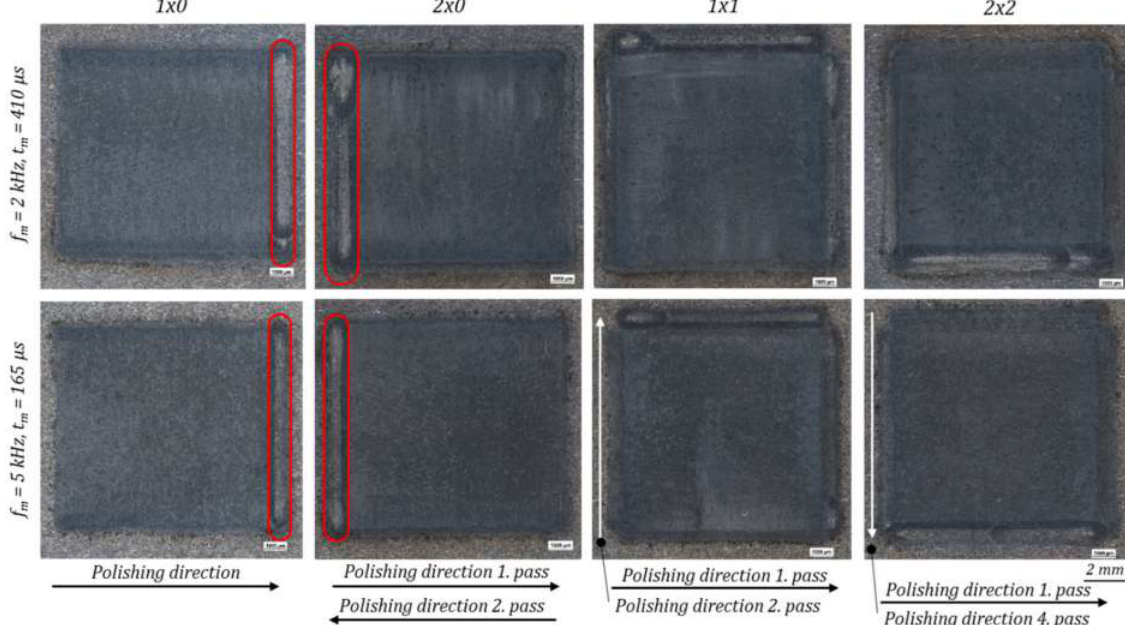
Figure 22. Microscopic images of the laser polished surface with multiple polishing passes (2 × 0, 1 × 1 and 2 × 2) with a 25-fold magnification considering the used modulation frequencies f m and the modulation time t m